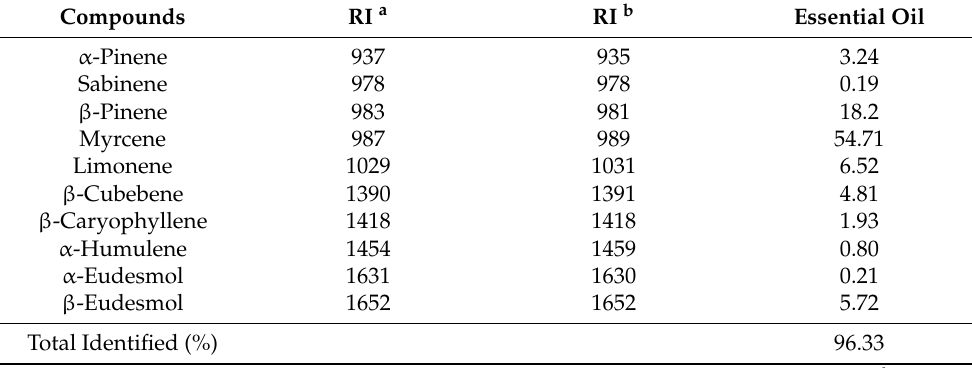
Table 1. Acritopappus confertus (Gardner) R. M. King & H. Rob. essential oil constituents.